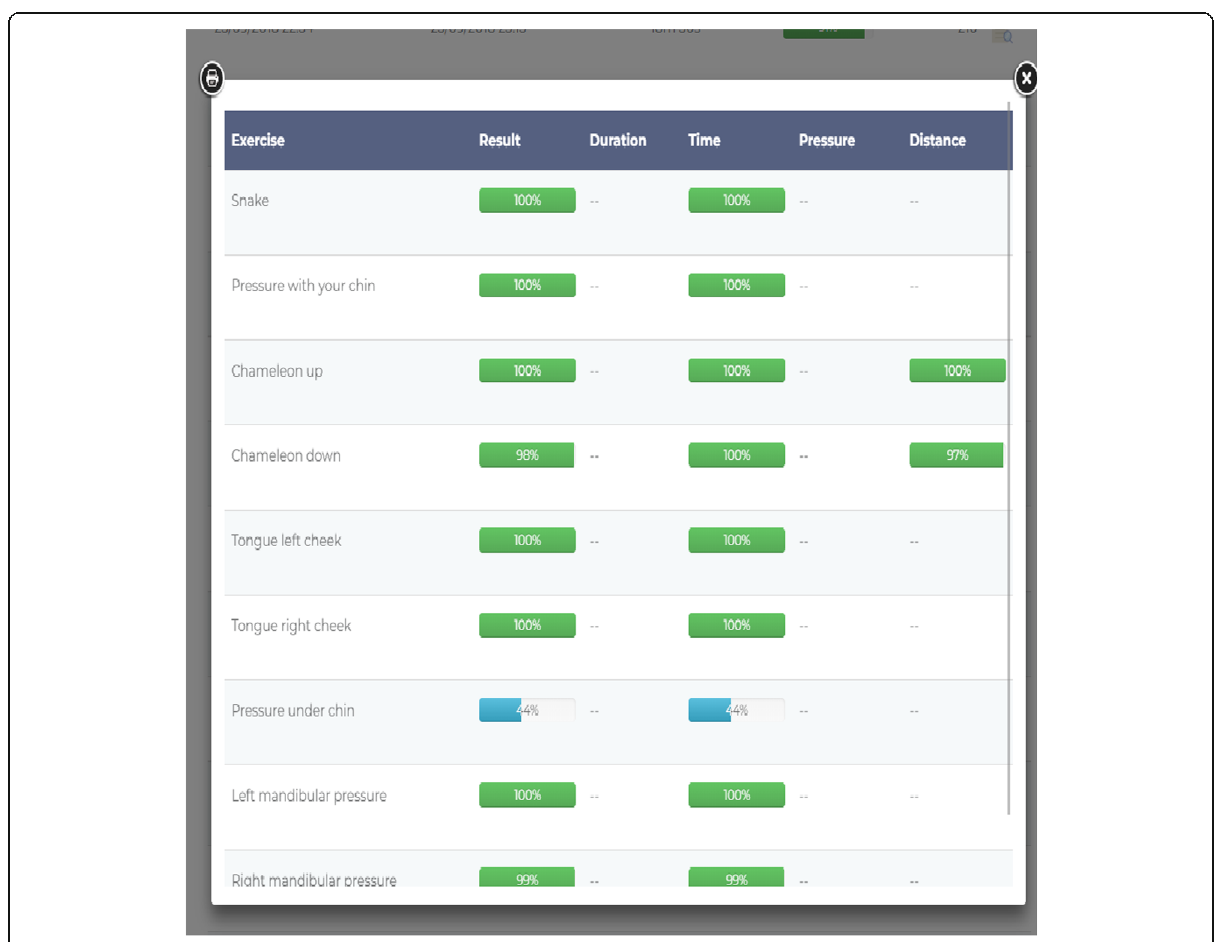
Fig. 4 Information obtained by Therapist about the accuracy and adherence of the performance of the exercises performed by